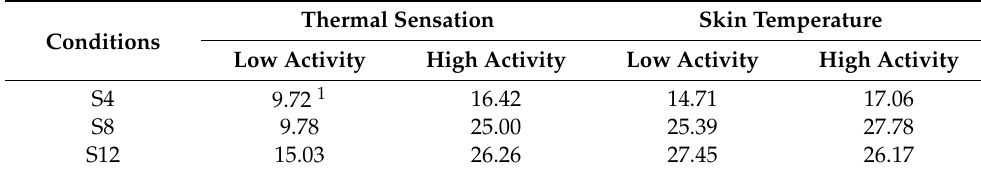
Table 4. The time taken to reach steady state for thermal sensation and skin